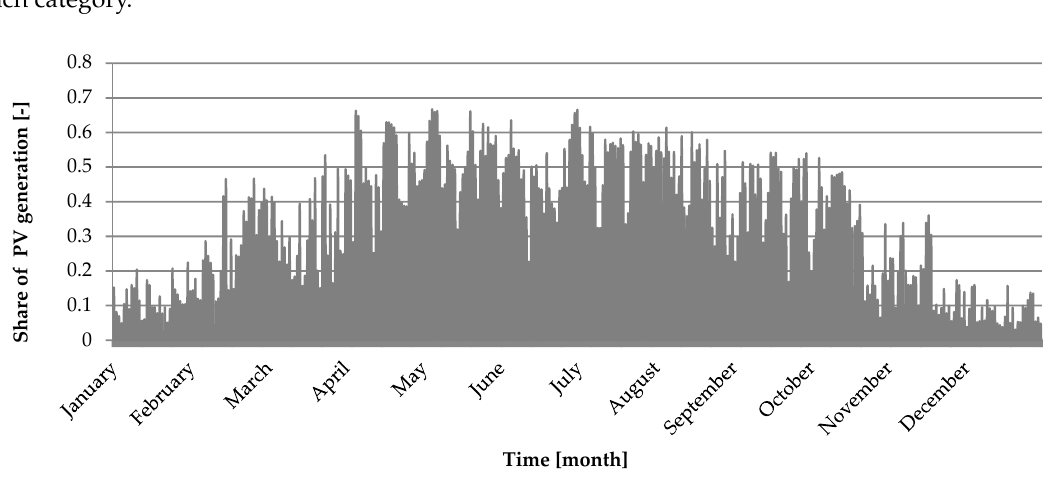
Figure A2. Share of total PV electricity generation to installed PV capacity in Germany in the year 2018 (own presentation based on the data from [35]).